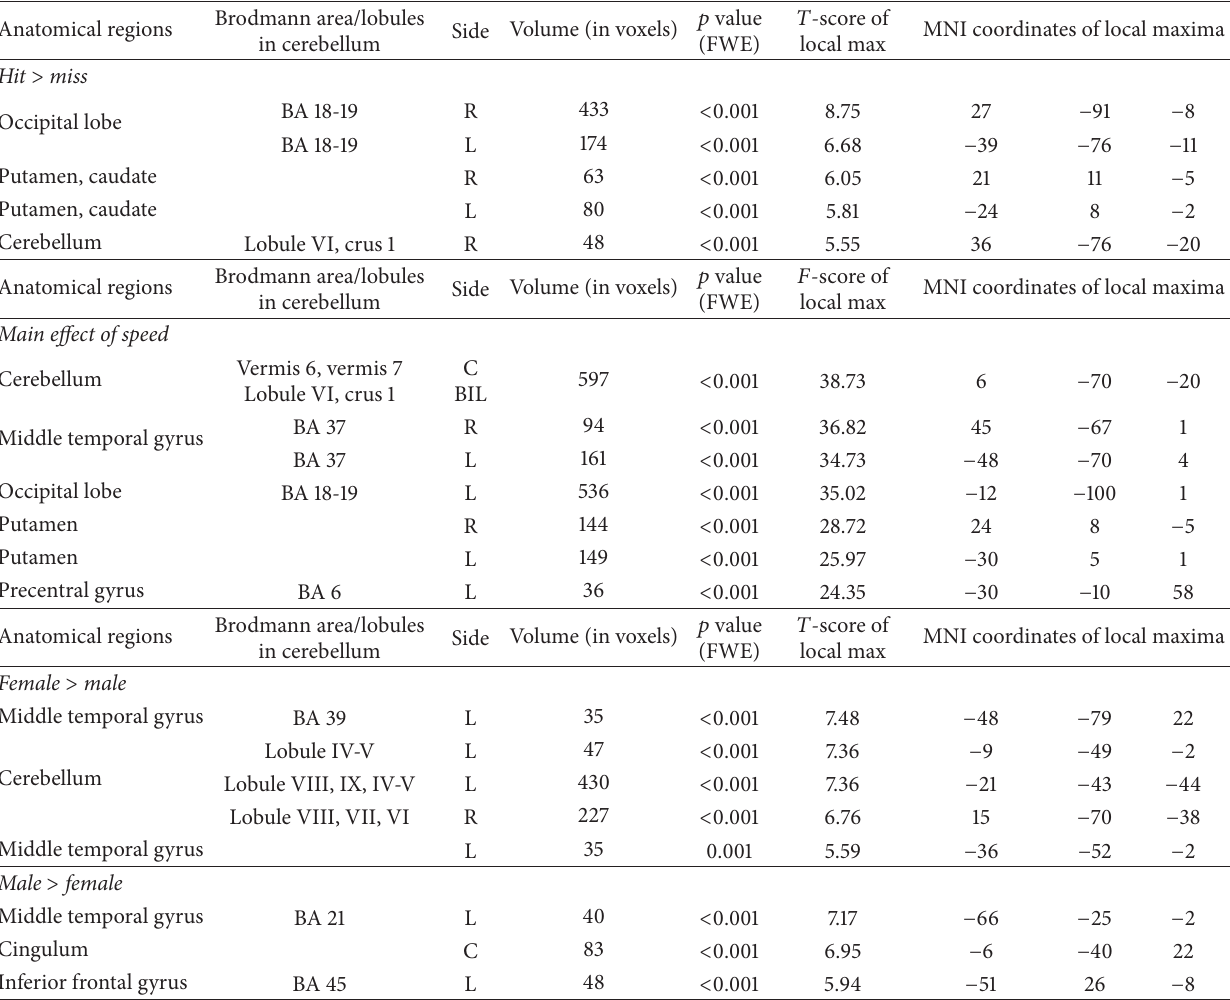
Table 1: Anatomical localization of clusters in the activation analysis (threshold of 𝑝 < 0.05 , FEW-corrected). Data provided for the main effect of hit versus miss, the effect of speed, and the gender